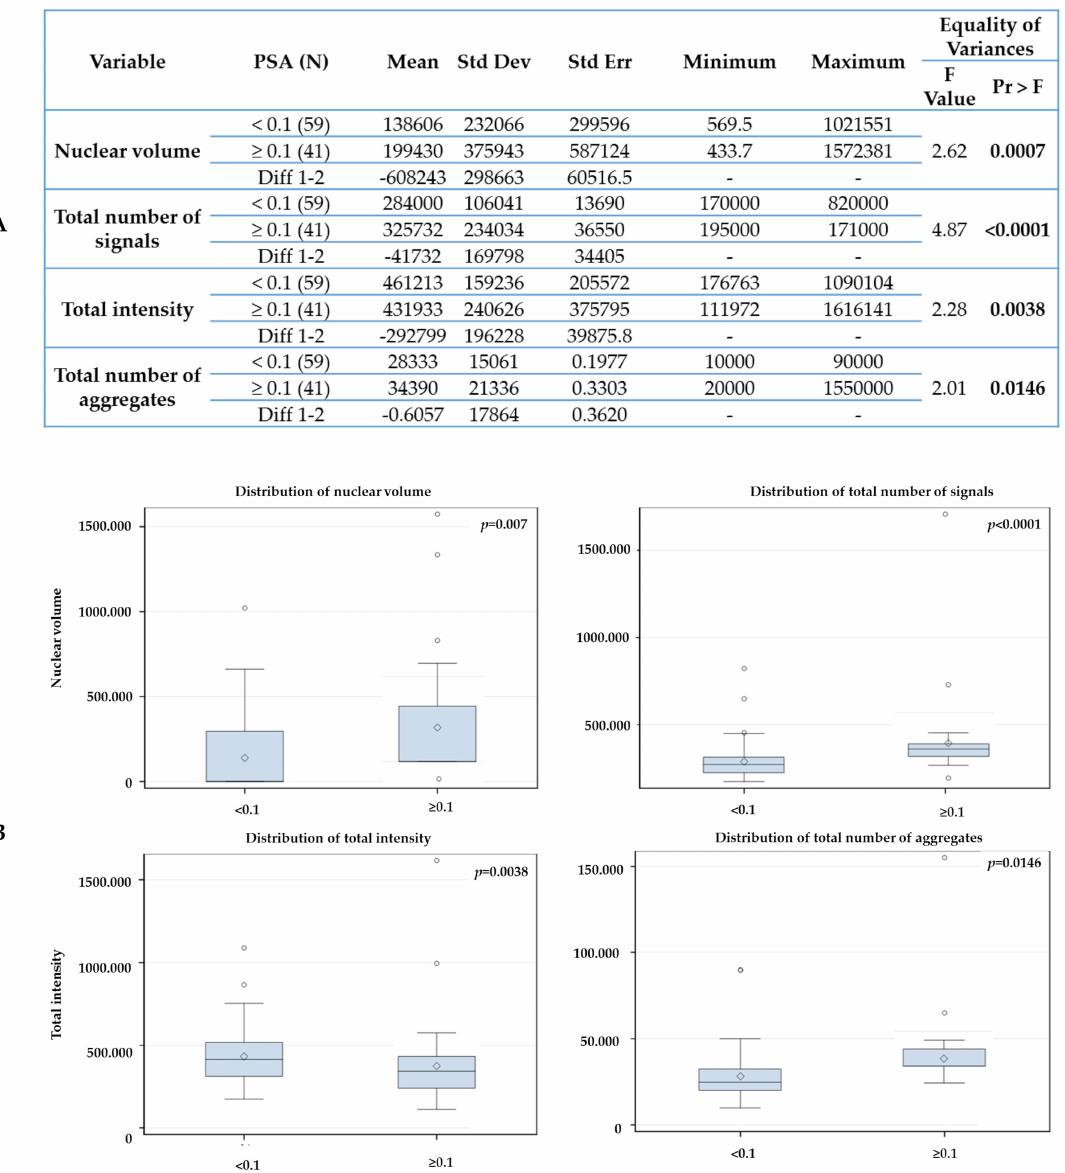
Figure 4. Statistical analysis comparing the telomeres parameters at 0 month with PSA end value at 6 months after androgen deprivation therapy using 0.1 ng / mL cuto ff ( A ). ( B ) Box-plots generated by Statistical Analysis Software v 9.4 (SAS, Cary, NC USA). The box is divided in the following way: —the median is the middle line, the 50th percentile- the top of box is the 75th percentile- the bottom box is the 25th percentile. Concerning the whiskers, the upper top of whiskers represent the max observation 1.5 × (interquartile range (IQR)—75th percentile minus 25th percentile), while the bottom of whiskers represent the minimum observation 1.5 × (1QR from 25th). The observations plotted are outliers—beyond the 1.5 × IQR or below. The sign in the box is the mean. The box indicates where 50 percent of the observations lies, extending to the whiskers indicates where most of the data lies and the points outside are